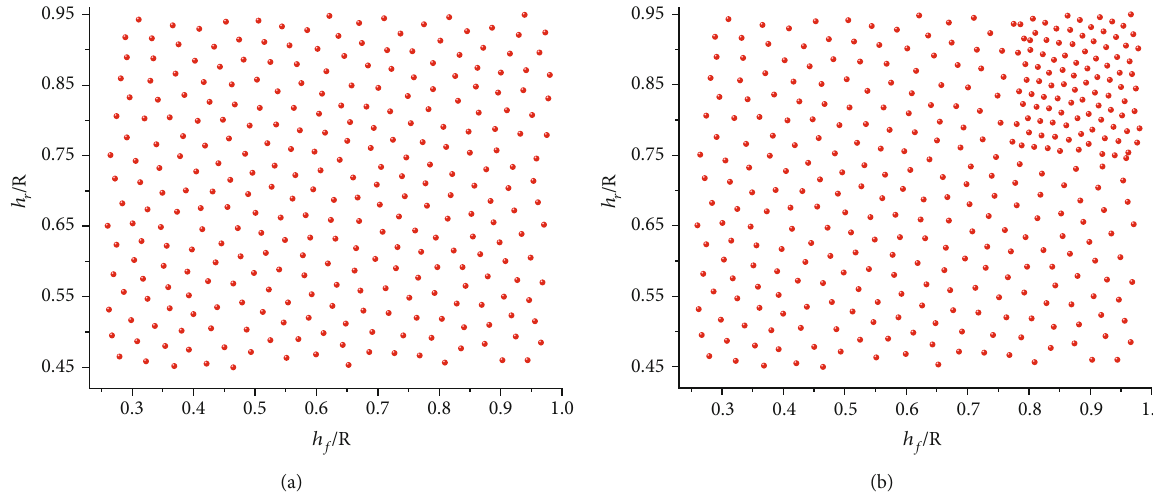
Figure 3: Schematic diagram of sampling points based on the OPLHS method.